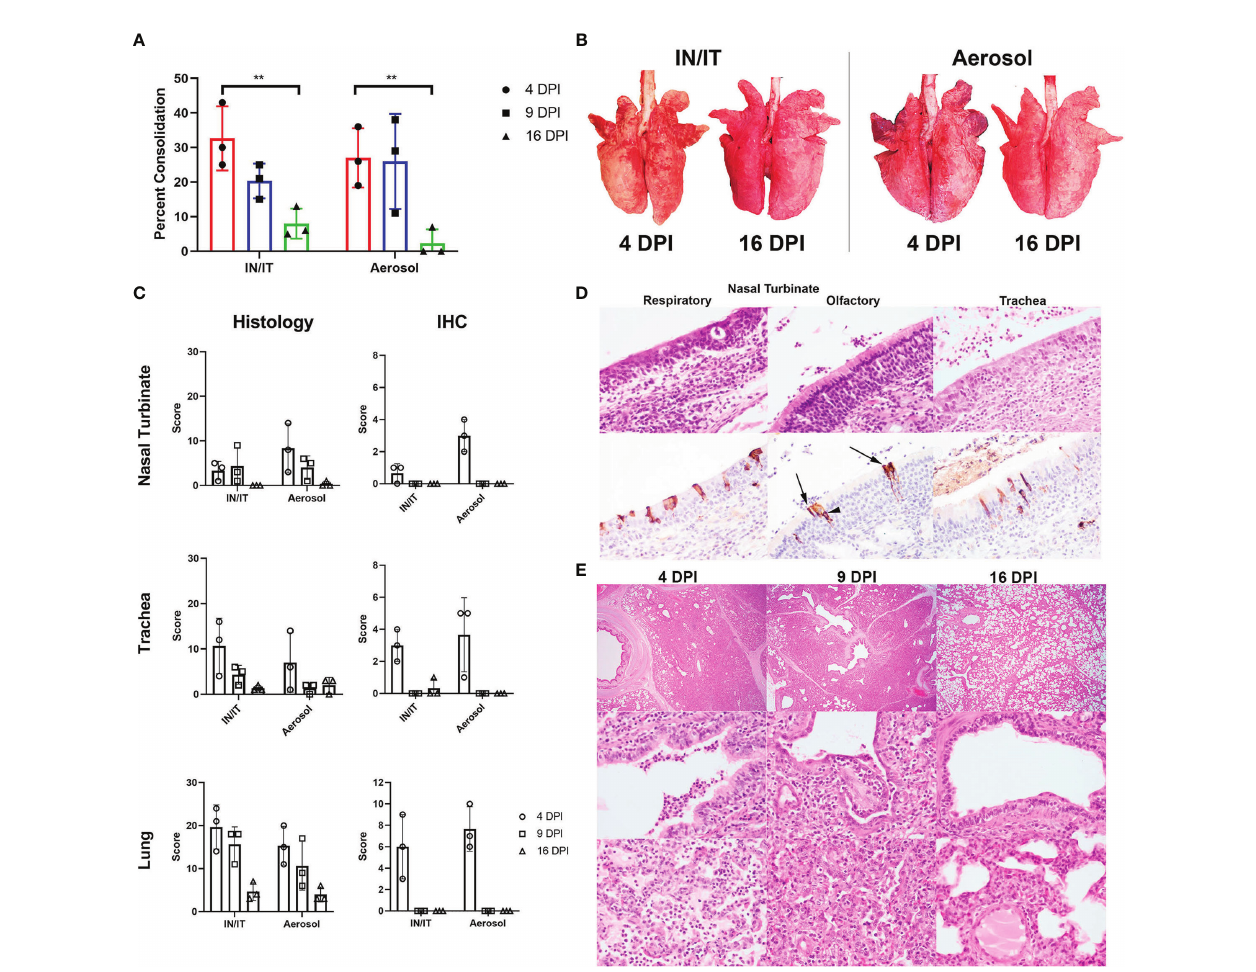
FIGURE 5 | Lung pathology after in vivo challenge with PRCV 135. Percent area of lung consolidation (A) . Statistical differences are highlighted by ** (p<0.005). Representative gross pulmonary pathology images at 4 and 16 DPI with both routes of infection (B) . Histopathology and immunohistochemical (IHC) scores for nasal turbinate, trachea, and lung (C) . The scores for each pig are a total of respiratory and olfactory nasal mucosa (nasal turbinate), cranial, middle, and caudal trachea segments (trachea) and right cranial, middle, and caudal lung lobes (lung). Representative histopathology and immunohistochemical images of the respiratory and olfactory component within the nasal turbinate and the trachea from animal P21-3425, aerosol inoculation, 4 DPI (D) . Immunolabelling for N in sustentacular (arrow) and olfactory epithelial cells (arrow heads) within the olfactory nasal mucosa. Pulmonary histopathological pro fi le following infection (E) . Acute broncho-interstitial pneumonia at 4 DPI with bronchiolar exudation, alveolar oedema and accumulation of alveolar macrophages. The air spaces remained collapsed whereby the alveolar wall is moderately expanded by in fl ammatory cells at 9 DPI. The bronchiolar epithelium is attenuated but re-epithelisation is also evident. By 16 DPI, the bronchiolar epithelium is hyperplastic, alveolar wall mildly expanded and with loose perivascular cuf fi ng. Sub-gross pulmonary (top row; 20x), bronchiolar (middle row; 400x) and alveolar areas (bottom row;